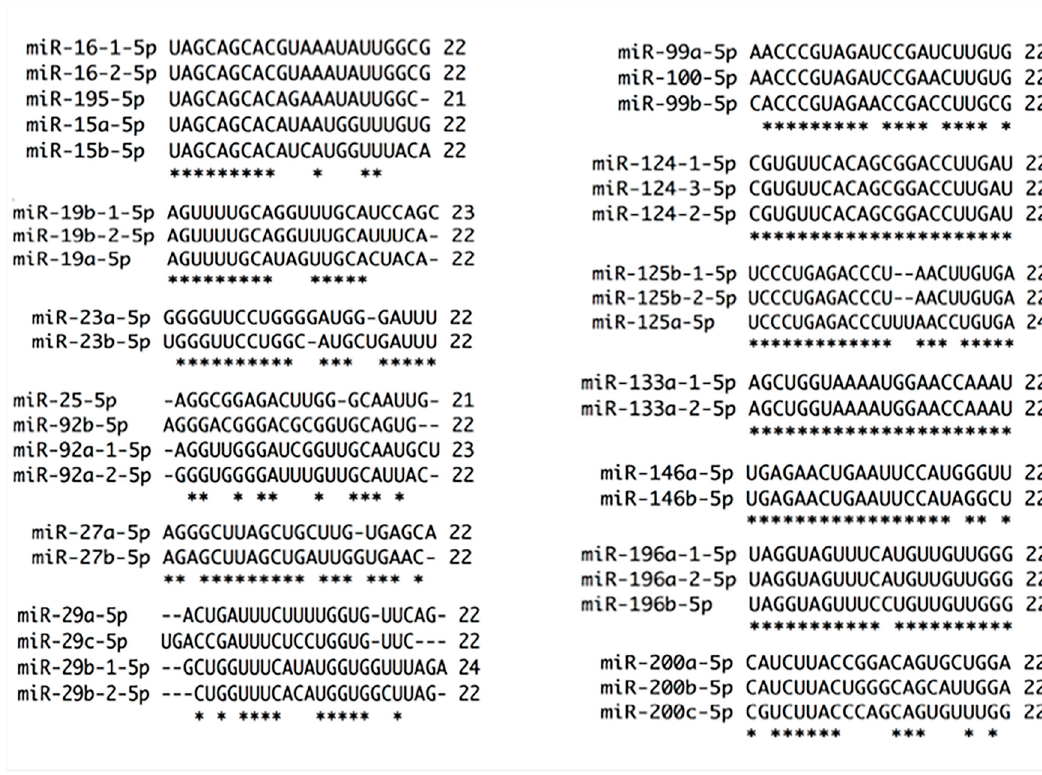
Figure 2. Alignments of miRNAs families by 5p strand selection and nt chain sizes. Thirteen miRNA families were chosen by strand and nt chain sizes. Almost all members of these families are 22 nt in length, except miR-195 (21 nt), miR-19b-1 (23 nt), miR-25 (21 nt), miR-92a-1 (23 nt), miR-29b-1 (24 nt), and miR-125a (24 nt). Of 13 miRNA families analyzed, only five use 5p arm as guide strand. miR-15 family shares 54.45%, miR-99 family 81.81%, miR-125 family 86.36%, miR-146 family 90.90% and miR-196 95.45% strand conservation. The rest of the families use the strand 3p, therefore, they show less 5p strand conservation. miR-19 family has 63.63 %, miR-23 family 77.27%, miR-25 family 45.45%, miR-27 family 72.72%, miR-29 family 45.54 %, miR-124 100%, miR-133 100% and miR-200 family 72.72% conservation. * at the bottom of the alignment indicates nt homology between family members.